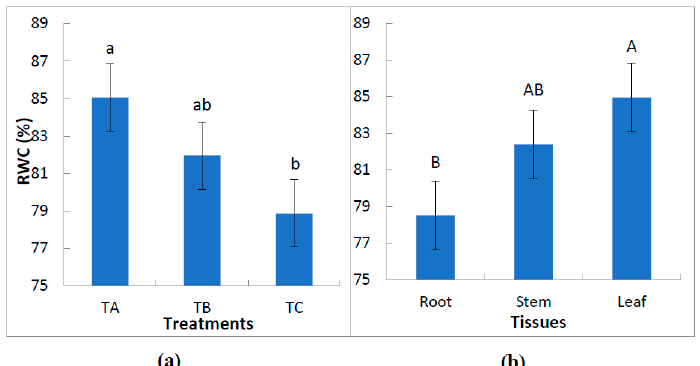
Figure 1. Effects of three water treatments (TA, well-watered (85% PC); TB, moderate water stress (65% PC); and TC, severe water stress (45% PC)) on the mean relative water content (RWC) of the leaves, stems and roots of lucerne seedlings ( a ), and the mean RWC of the tissues in the three water treatments ( b ). Means with the same upper-case letter are not significantly different among different plant tissues. Means with the same lower-case letter are not significantly different among different water treatments. There was no significant interaction between tissues and water treatments.